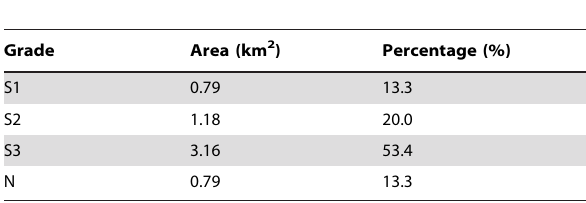
Table 10. Areas suitable for use as grassland in